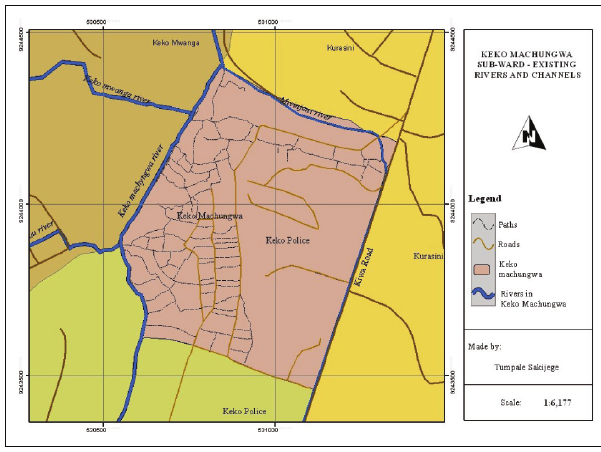
Sourc e: Map created by the authors for the purposes of this study FIGURE 2: Keko Machungwa informal settlement traversed by seasonal streams in Dar es Salaam,